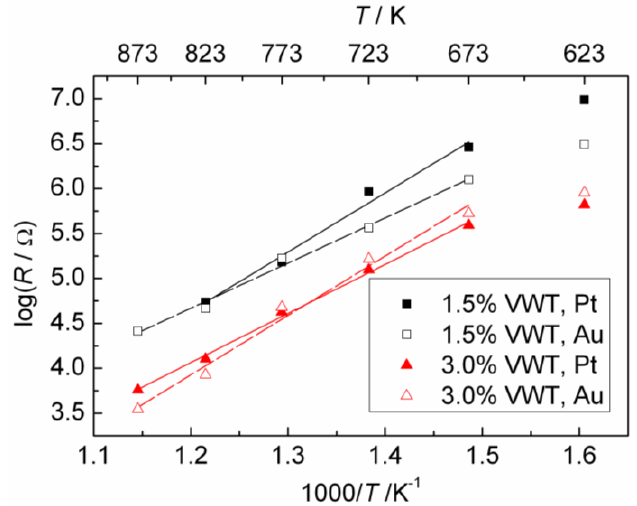
Figure 5. Arrhenius-type representation of the sensor resistance in compressed air (without SO 2